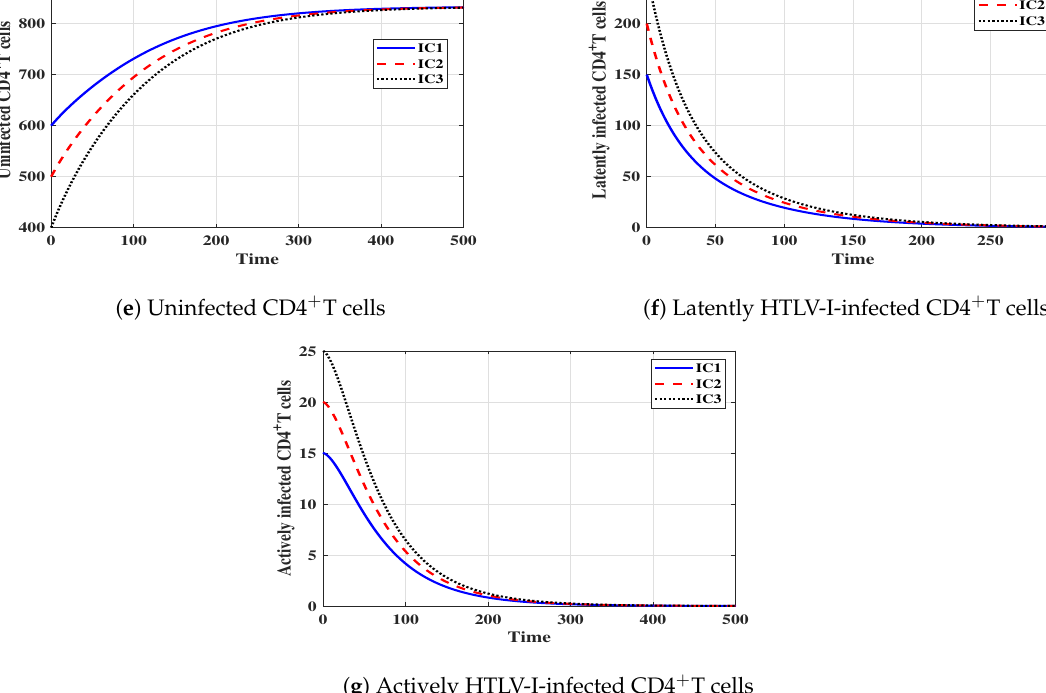
Figure 1. Solutions of system (7)–(13) with initial conditions IC1–IC3 in Case